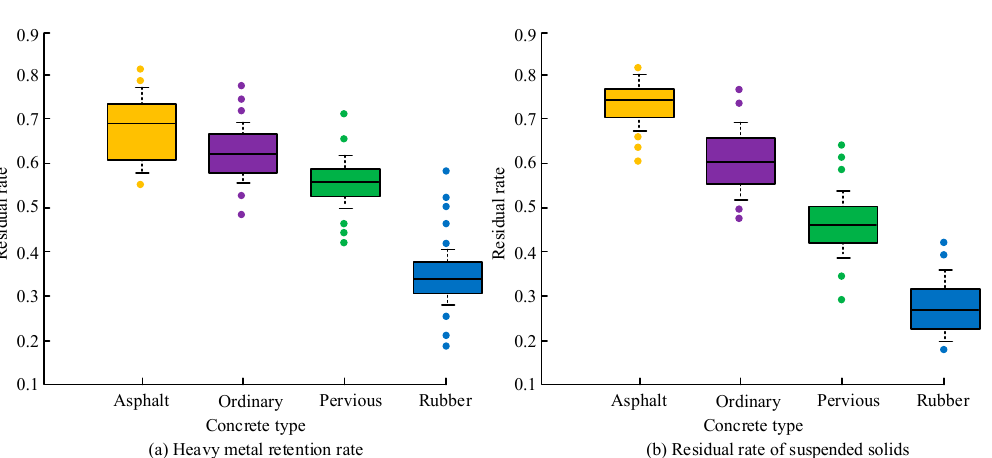
Figure 6. Comparison of pollutant retention rate under different concrete types. ( a ) Heavy metal retention rate; ( b ) Residual rate of suspended solids.